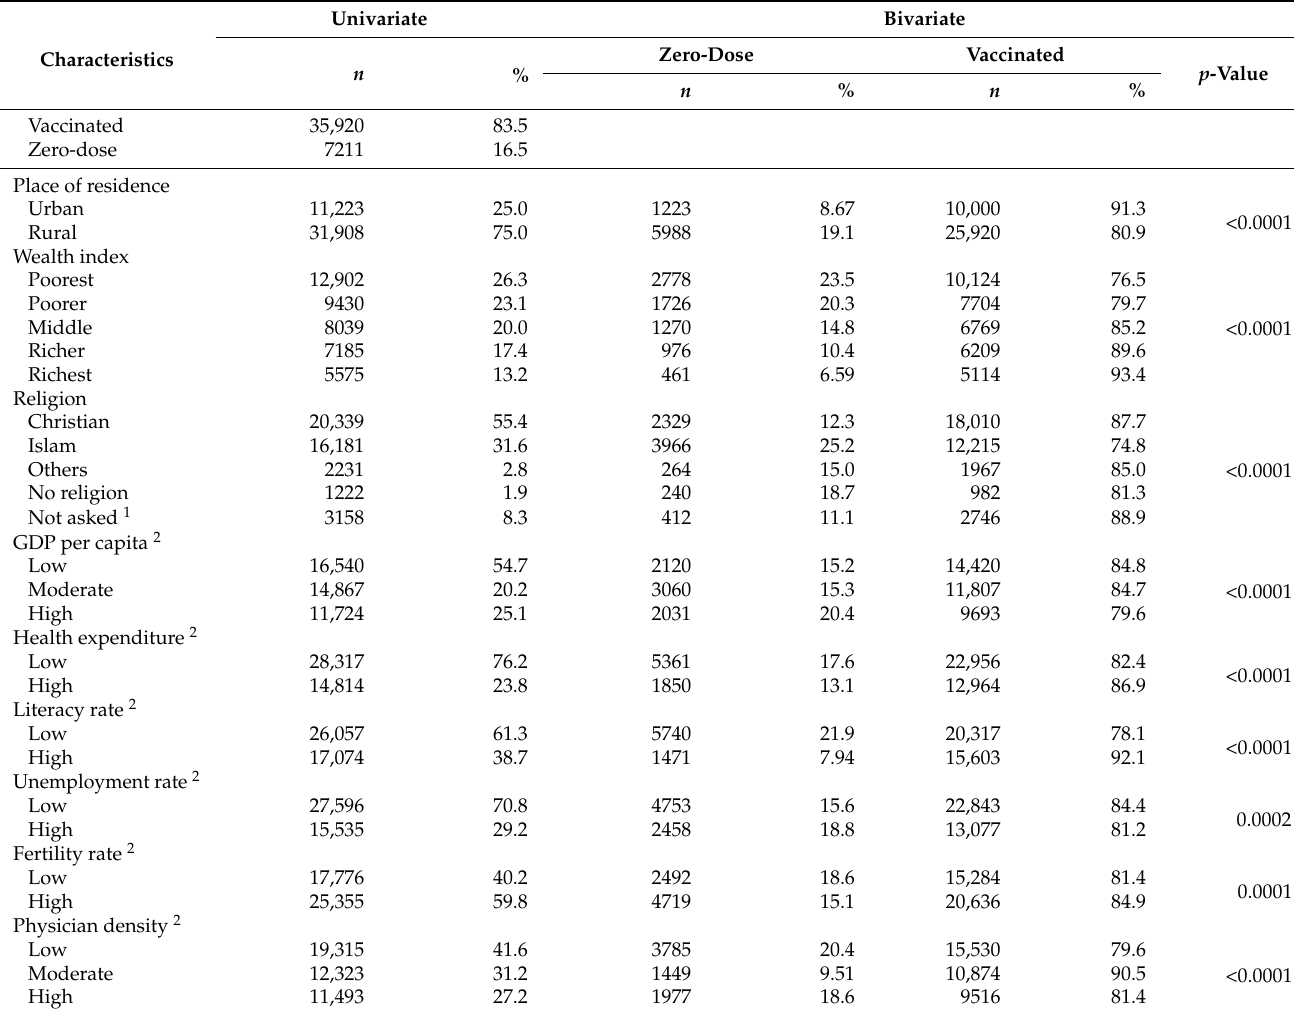
Table 3. Baseline characteristics and bivariate analysis of contextual factors associated with